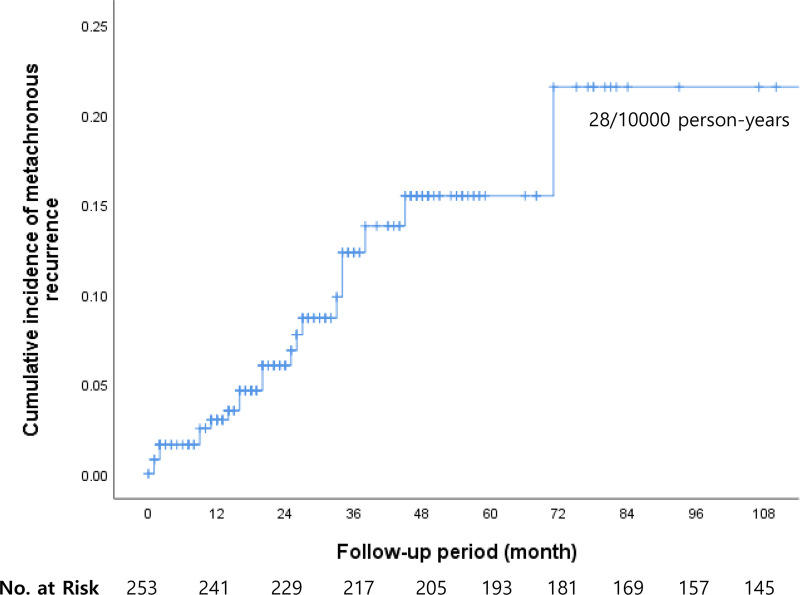
Metachronous recurrence after endoscopic submucosal dissection for superficial esophageal squamous cell carcinoma occurred in 8.3% of the patients allocated to surveillance (incidence, 28/10000 person-years).